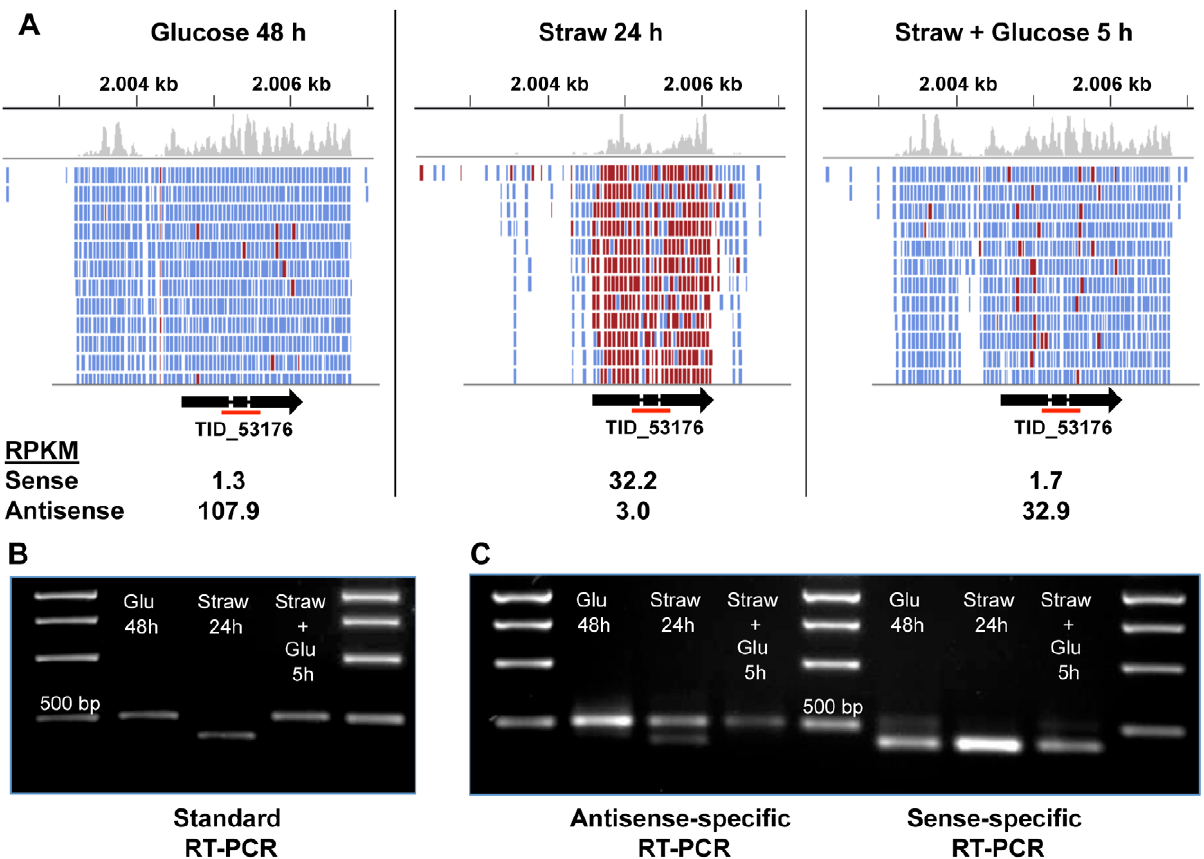
Figure 4. Sense and antisense transcription from TID_53176. (A) Alignment of RNA-seq reads to the TID_53176 genome region under each condition. Reads represented in blue are antisense, those in red are sense. The Figure was constructed using the Integrative Genomics Viewer [62]. (B) Oligo(dT) primed RT-PCR using TID_53176 specific primers. The expected band size from the spliced sense transcript is 411 bp and the size of the non-spliced antisense transcript is 524 bp. The red line under the gene model in panel A indicates the amplified region. (C) Strand-specific RT-PCR. One of the standard PCR primers, with an added sequence tag (Table S5), was used to synthesise cDNA from one strand only and then the PCR step was performed by using the tagged sequencing primer together with the opposing gene-specific primer. The larger band is only seen in the antisense-specific reaction, confirming it does represent an antisense transcript. The smaller band is the only band present in the sense-specific